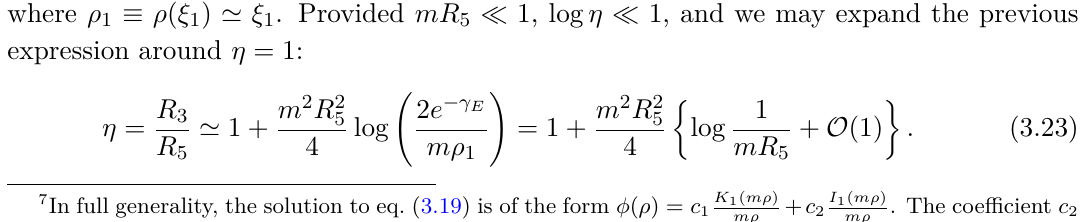
Figure 3: Diagram for ⇢ 1 and ⇢ 2 Figure 6: Diagram for ⇢